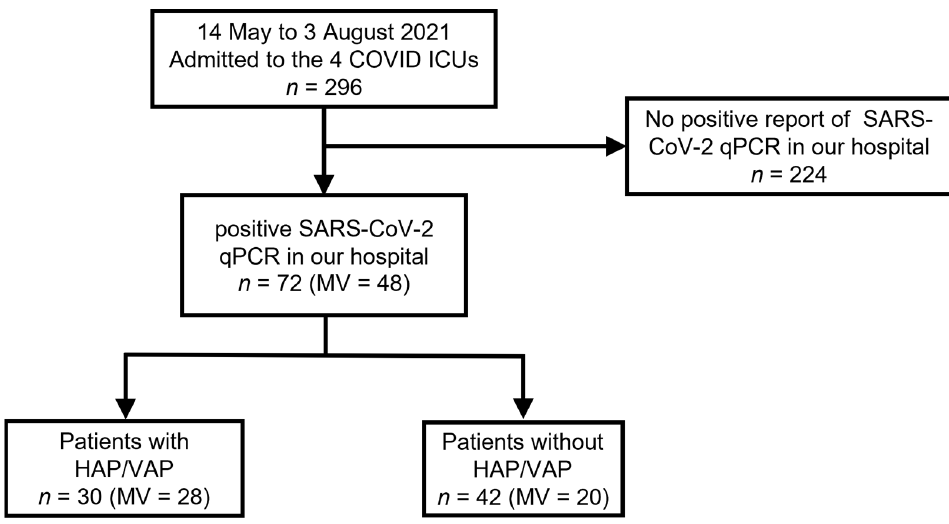
Figure 1. Flow chart of study. COVID: coronavirus disease; ICU: intensive care unit; SARS-CoV-2: severe acute respiratory syndrome coronavirus 2; PCR: polymerase chain reaction; HAP: hospital- acquired pneumonia; VAP: ventilator-associated pneumonia.